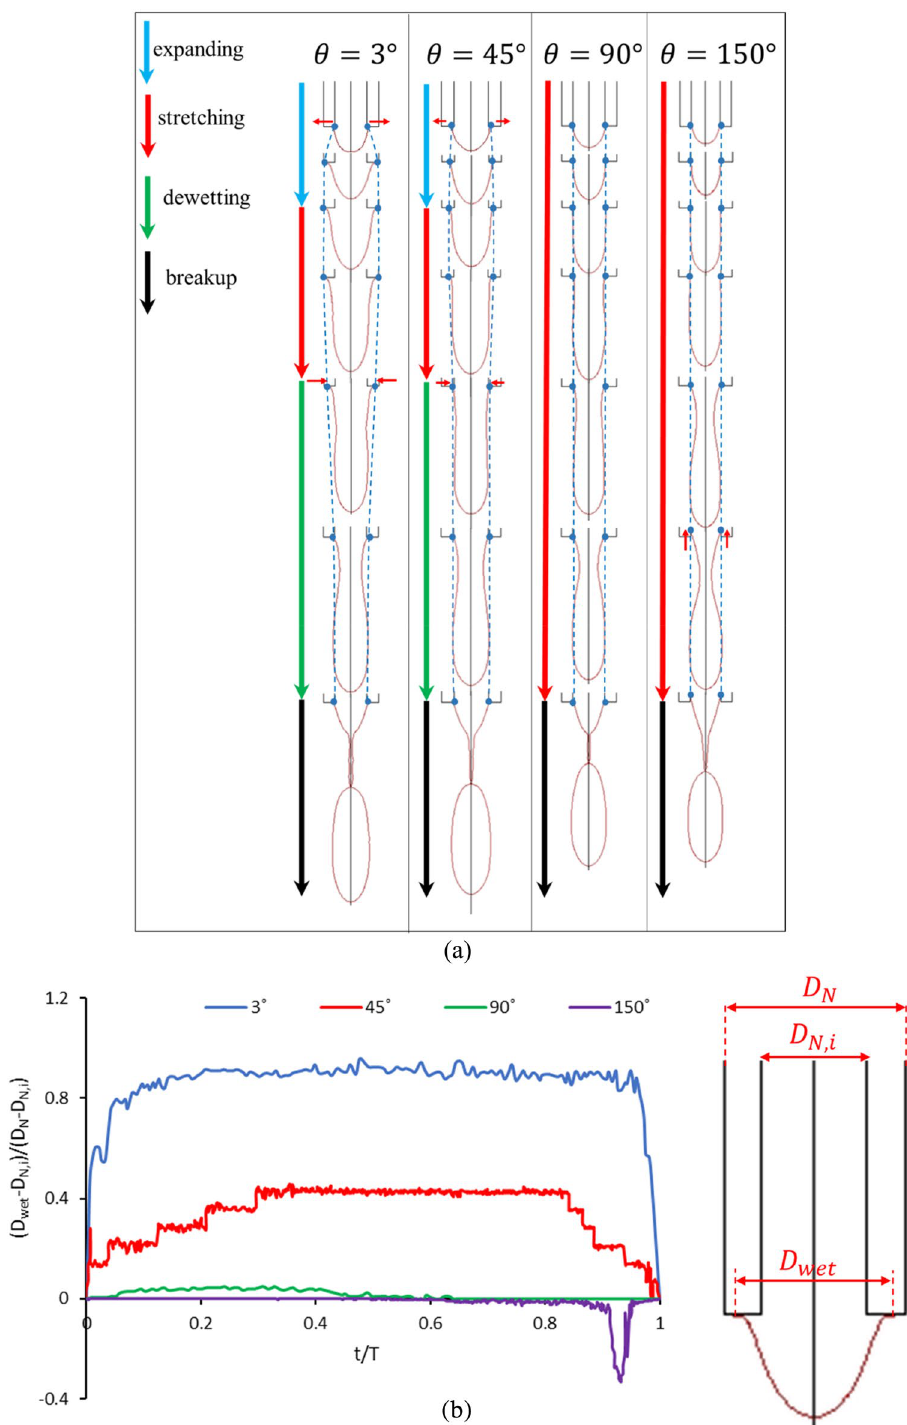
Figure 11. ( a ) Comparison of the droplet formation process and wetted diameter of the nozzle for various contact angles of 3°, 45°, 90°, and 150°. The four mentioned stages are only valid for the contact angles of 3° and 45°. Ferrofluid contact points with the nozzle’s surface are depicted by blue points, and the blue dashed lines show the process of expanding and dewetting. ( b ) Instantaneous dimensionless wetted diameter for contact angles of 3°, 45°, 90°, and